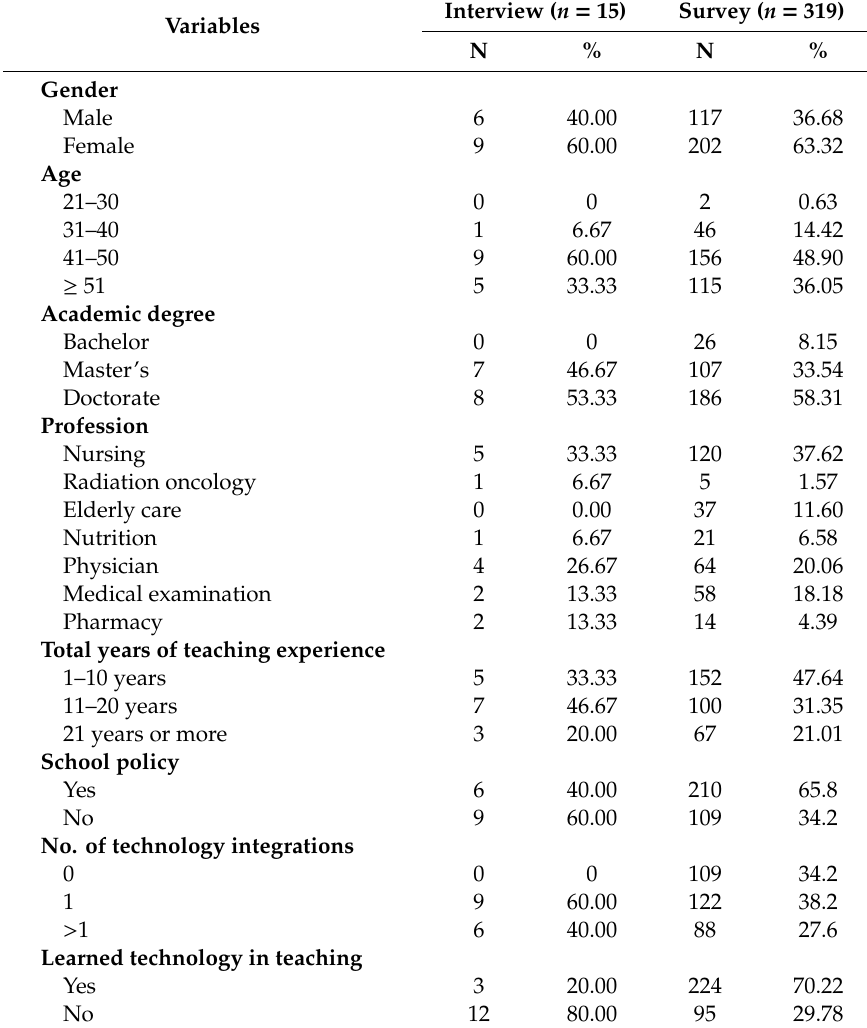
Table 1. Descriptive characteristics of